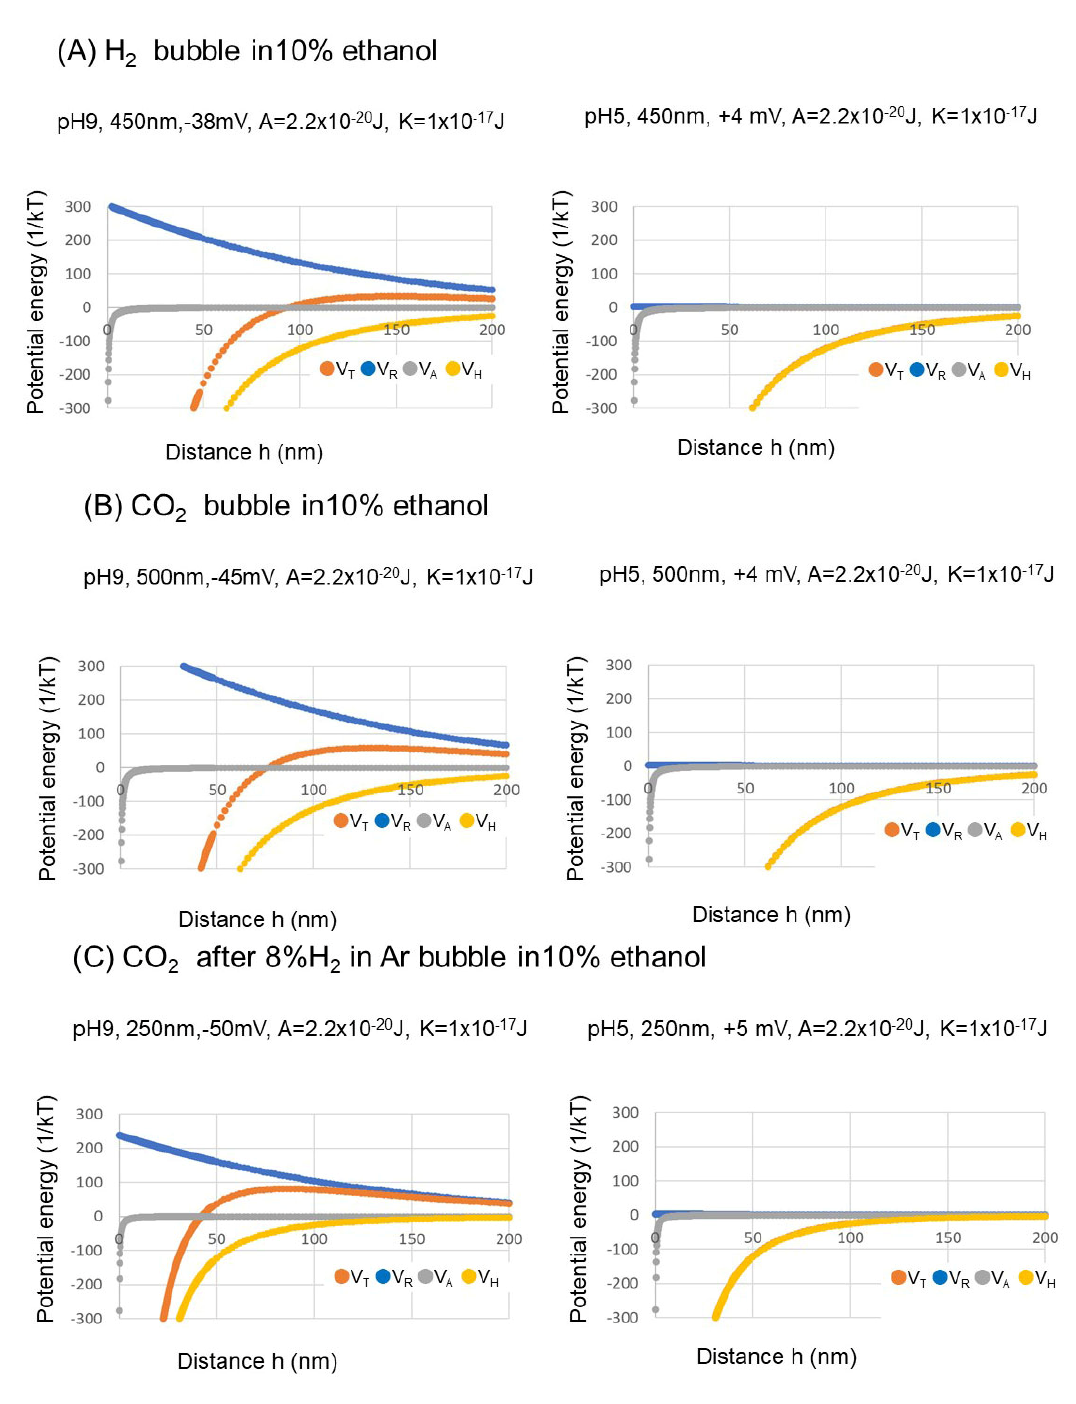
Figure 7. Total potential energy ( V T ), electrostatic interaction energy ( V R ), van der Waals interaction energy ( V A ), and hydrophobic interaction energy ( V H ) as a function of the surface-to-surface distance between two nanobubbles at pH 9 and pH 5 of three kinds of gas nanobubbles in 10 vol.% ethanol aqueous solution.